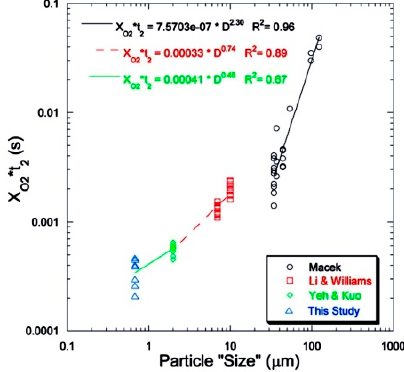
Figure 2. Comparison of the full-fledged combustion times of B particles (Macek [6], Li [7], Yeh [8], this study [9]). Reproduced from [9], with permission from Elsevier, 2009.